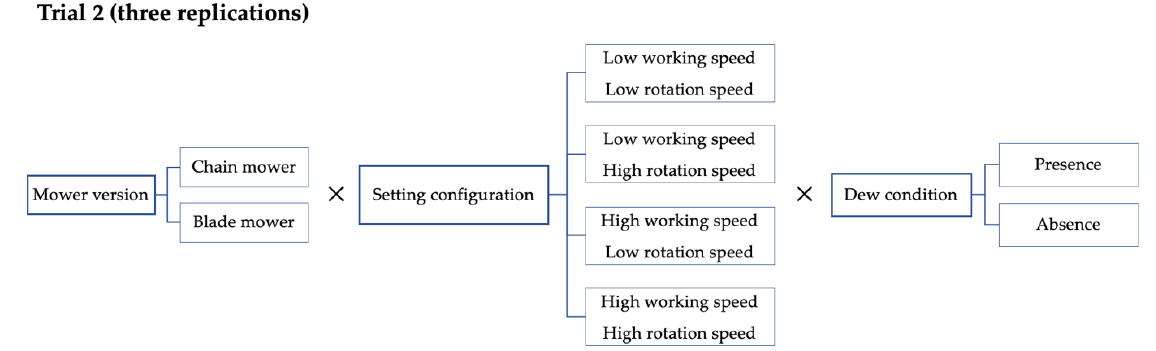
Figure 5. Diagram describing tested factors and relative levels in the second trial.